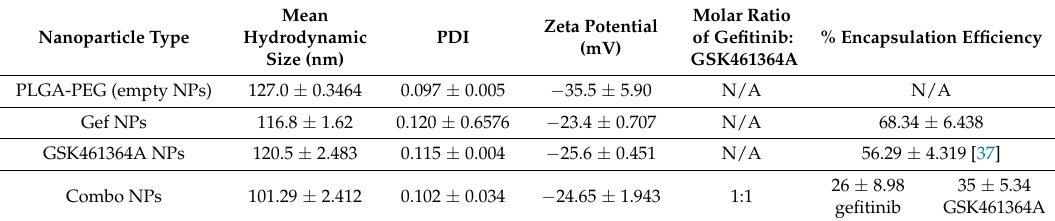
Table 1. Characterization of empty, single drug, and dual drug loaded PLGA-PEG NPs.